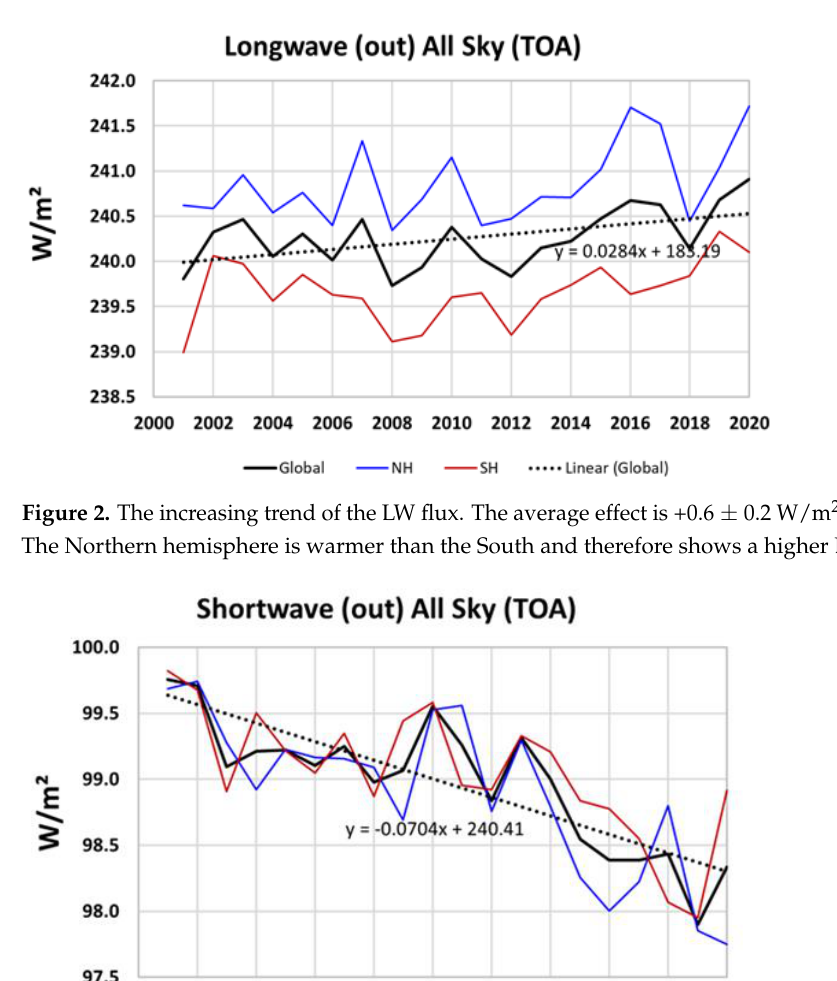
Figure 1. The weakly declining annual mean value ( −0 .07 ± 0.06 W/m 2 ) of the incoming solar irradiation for the globe, NH and SH. The Southern hemisphere obtains ca. 0.7 W/m 2 more than the North due to the eccentric orbit and the inclined axis of the Earth.